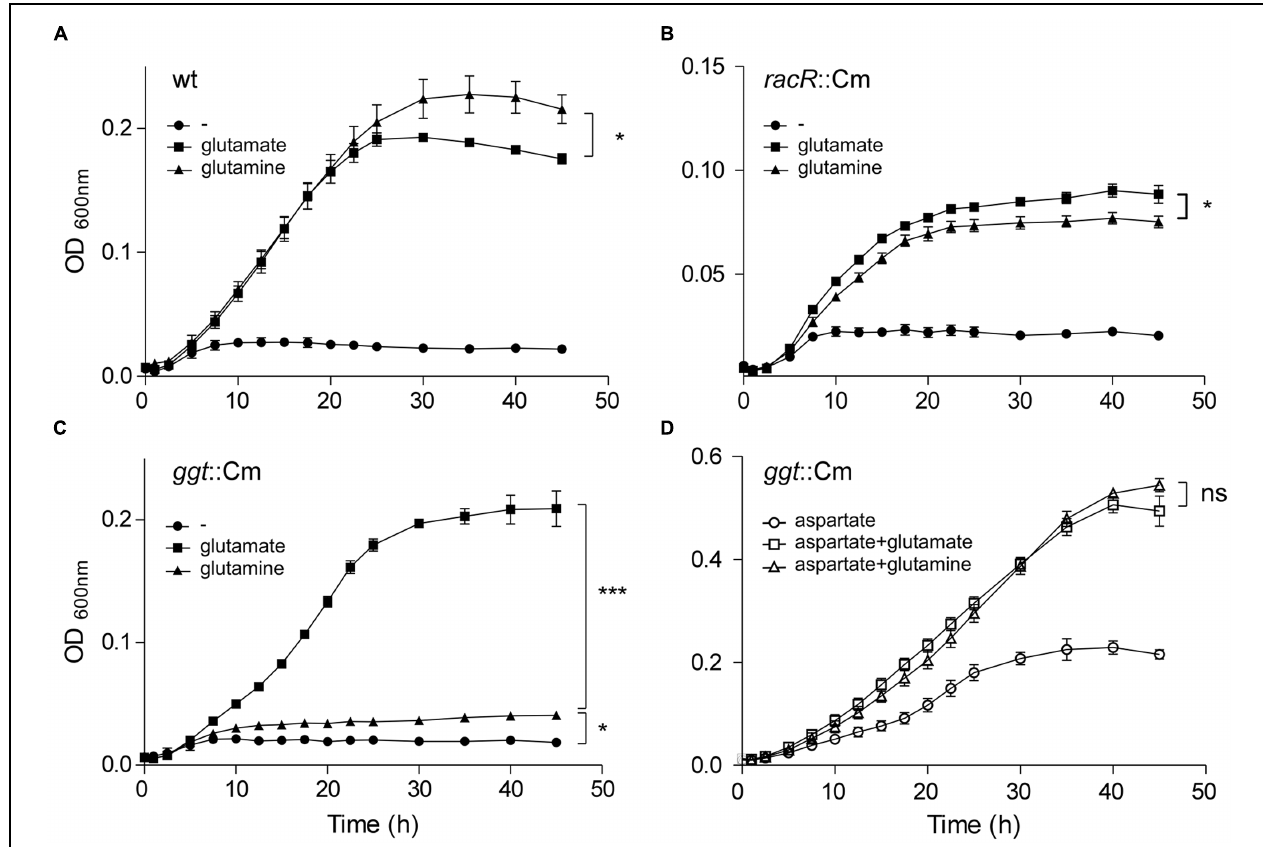
FIGURE 5 | The RacRS system is important for the generation of glutamate out of glutamine. Growth curves were generated of the wt 81116 (A) , the racR (B) , and ggt (C) mutants grown in DMEM (circles) or with the addition of 10 mM glutamate (squares) or 10 mM glutamine (triangles) at 1% O 2 with the addition of 10 mM TMAO as electron